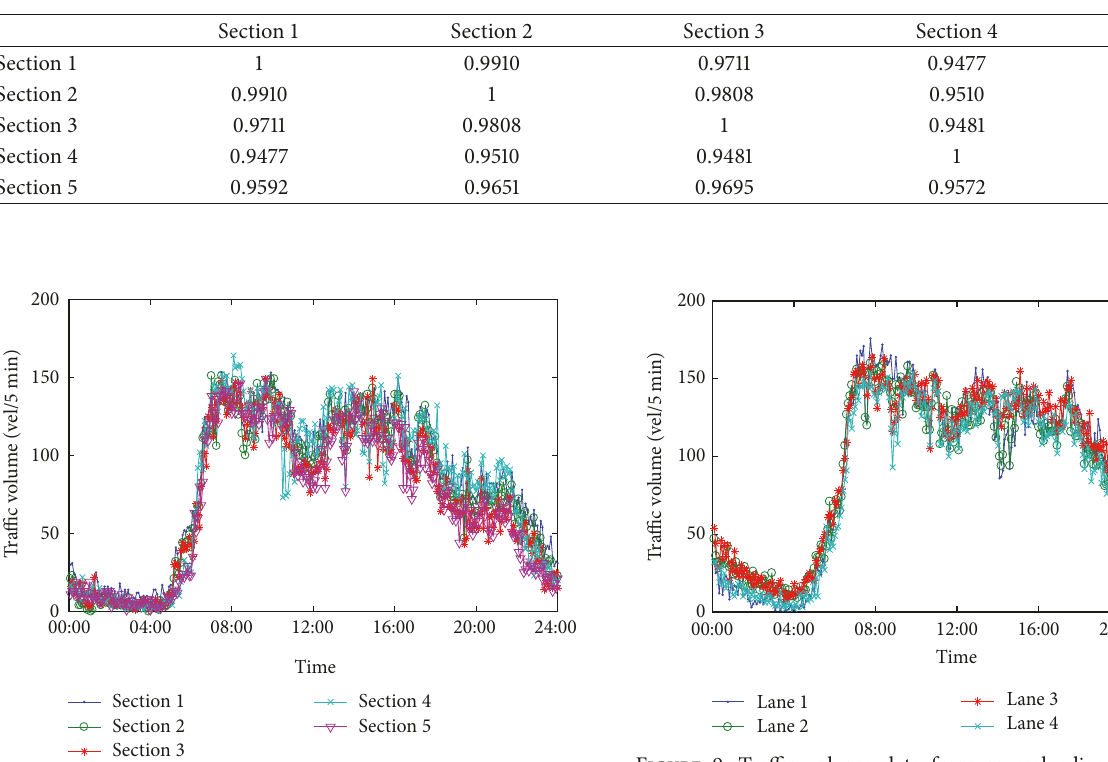
Figure 8: Traffic volume data from several adjacent sections in a lane of the urban expressway.